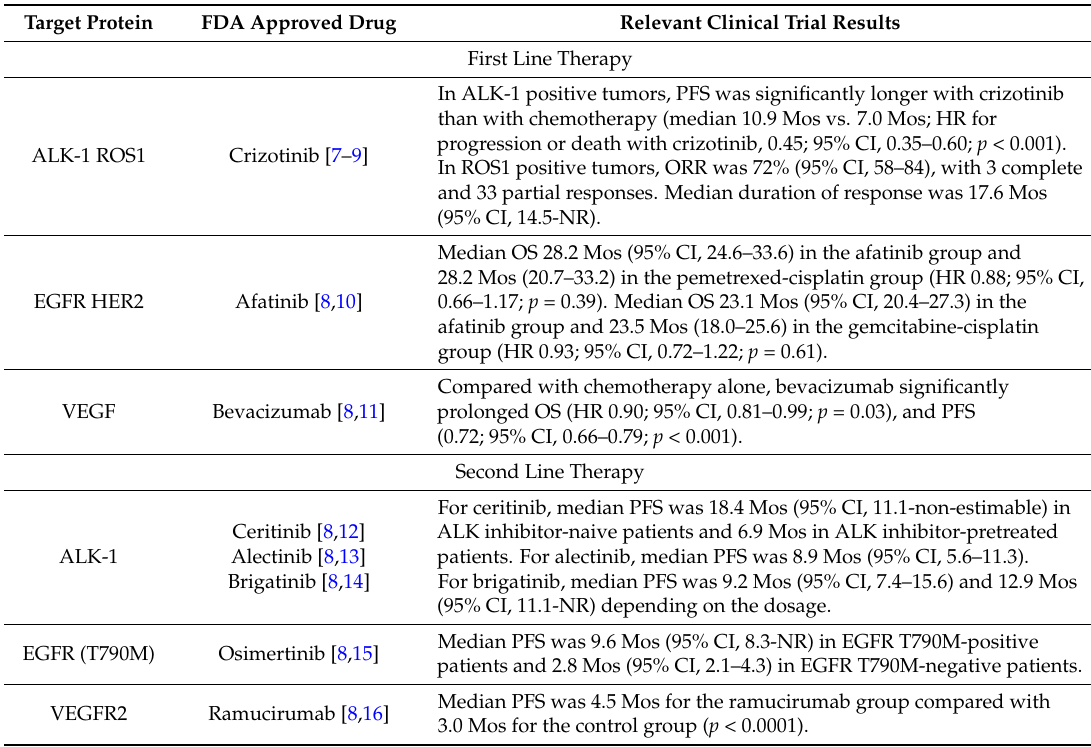
Table 1. Target therapy for